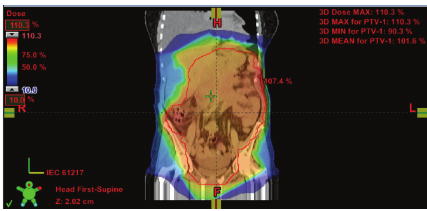
Figure 3: 3D dose distribution for radiotherapy planning of abdom- inal